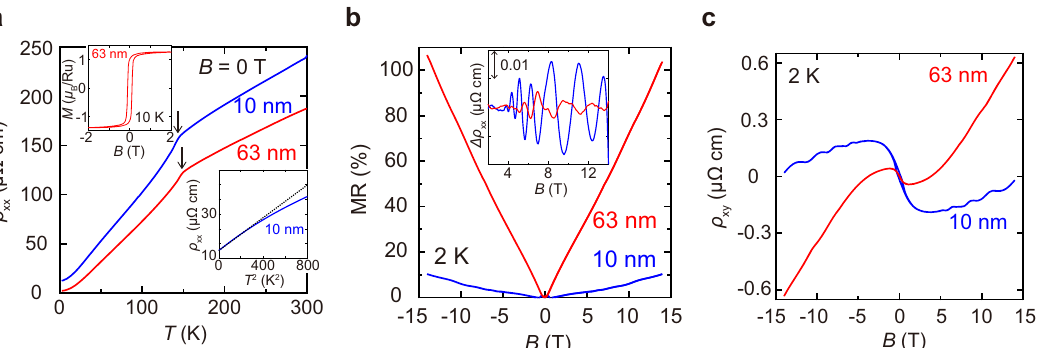
Fig. 2 Thickness dependence of the transport properties. a Temperature dependence of longitudinal resistivity ρ xx for the SrRuO 3 fi lms with t = 10 and 63 nm at zero magnetic fi eld. The arrows indicate the ferromagnetic transition temperatures. The left inset shows the magnetization vs. magnetic fi eld curve for the SrRuO 3 fi lm with t = 63 nm at 10 K with B applied in the out-of-plane [001] direction of the SrTiO 3 substrate. The right inset shows the ρ xx vs. T 2 plot with the linear fi tting (black dashed line). b Thickness t dependence of MR ( ρ xx ( B ) ρ − ρ xx (0 T))/ xx (0 T) at 2 K with B applied in the out-of-plane [001] direction of the SrTiO 3 substrate ( components obtained by subtracting a polynomial function up to the eighth order. c Thickness t dependence of transverse resistivity ρ xy at 2 K with B applied in the out-of-plane [001] direction of the SrTiO 3 substrate ( θ = 90°). Here, the ρ xx , MR, and ρ xy data for the SrRuO 3 fi lm with t = 63 nm are the same data reported in ref. 27